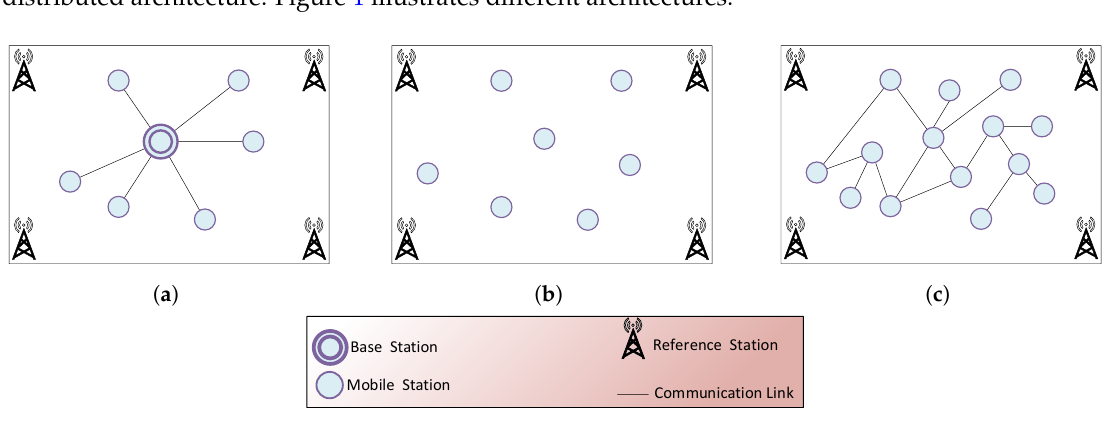
Figure 1. Position evaluation: ( a ) central, ( b ) decentral and ( c )